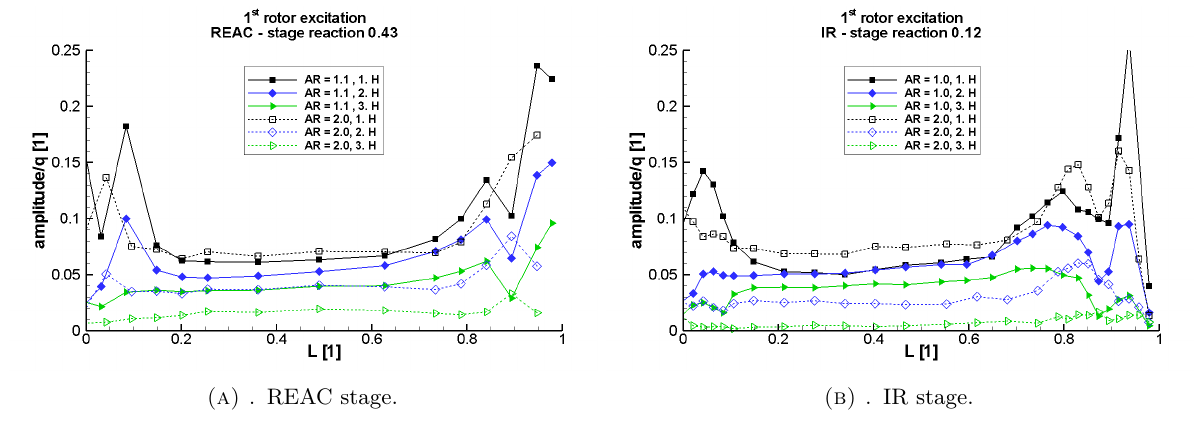
Figure 2. The first rotor excitation for two stator aspect